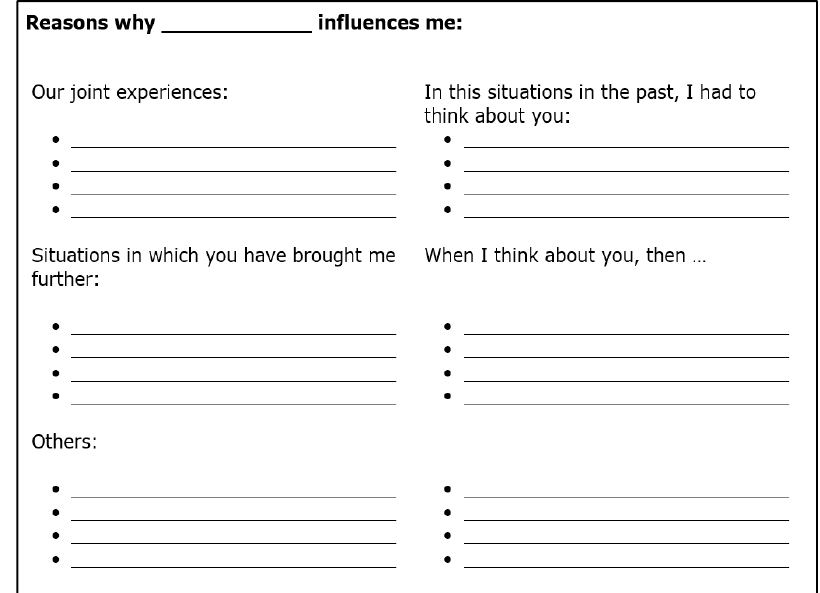
Figure A2. Worksheet for the ‘Gratitude song’.